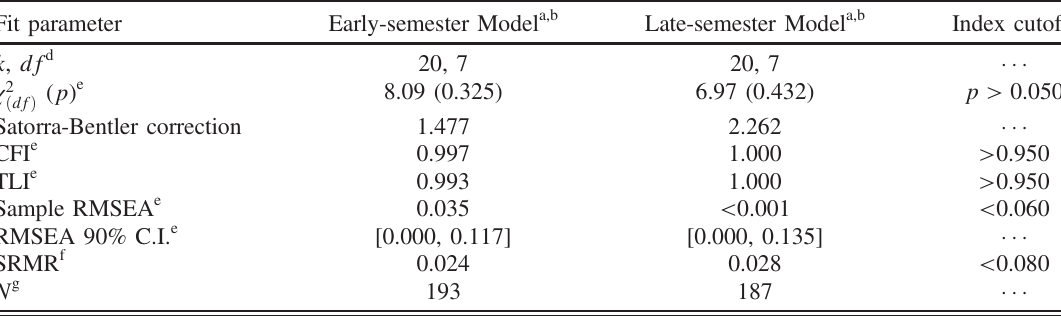
TABLE I. Social-belonging survey confirmatory factor analysis model fit indices.